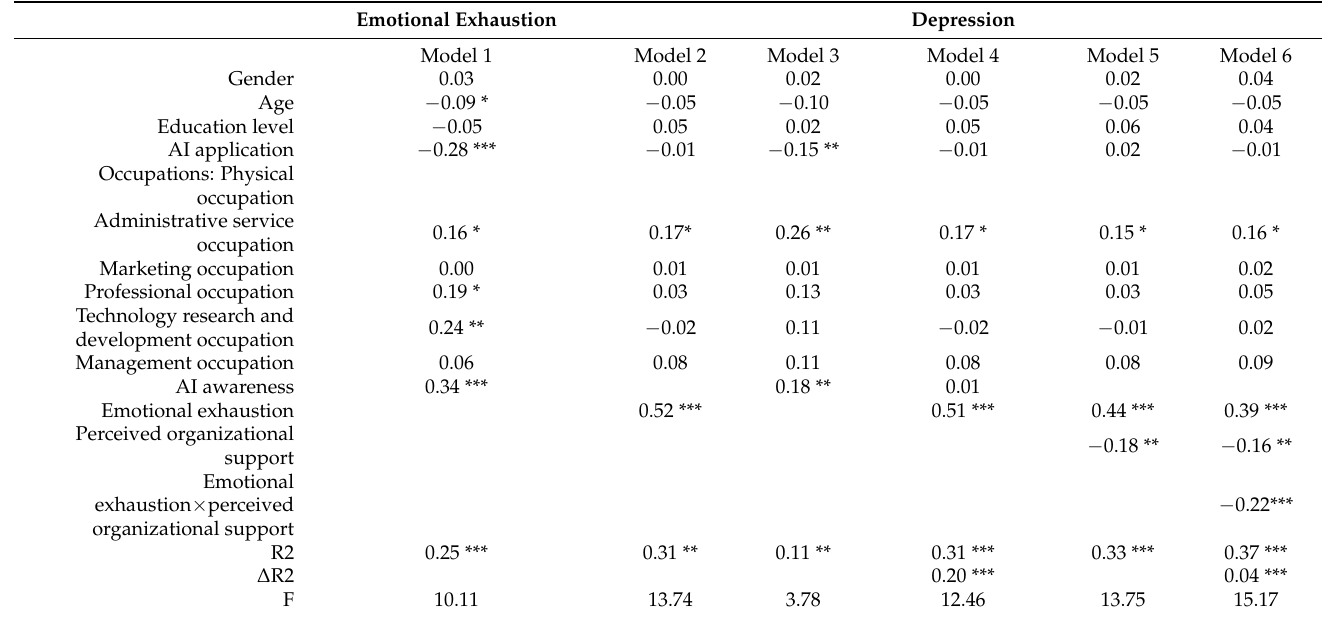
Table 3. Multiple linear regression analysis